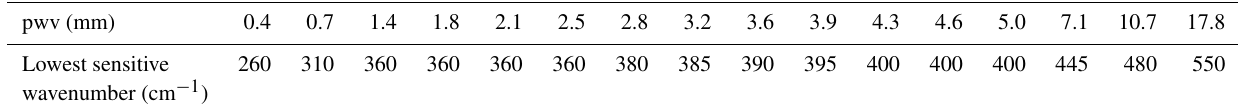
Table 2. Data points from Fig. 6 for the case at 67 ◦ N, 18 ◦ E. Note: pwv is the true precipitable water vapour content of the retrieved scene, and the lowest sensitive wavenumber is the minimum wavenumber at which the retrieved emissivity satisfies the criterion in Eq. (8). pwv